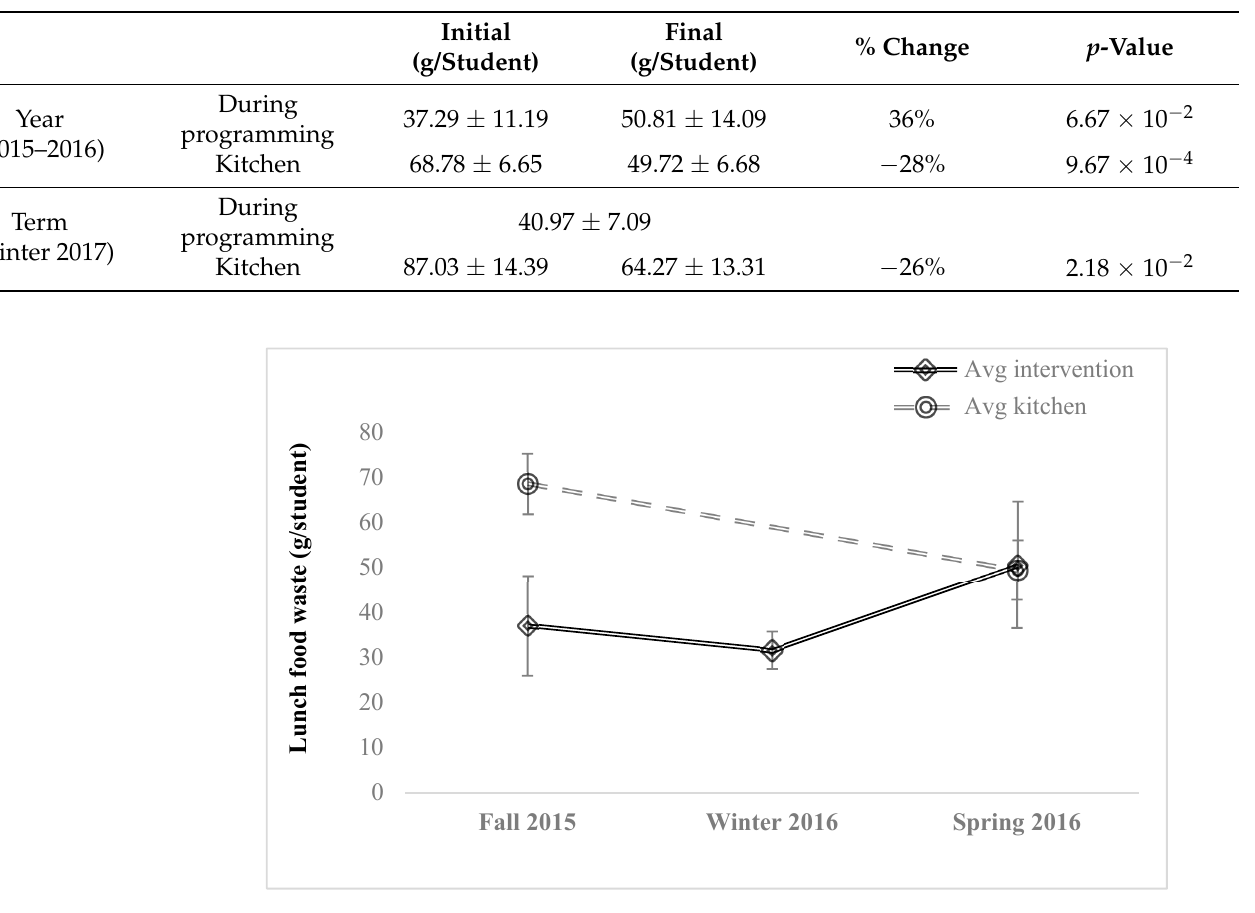
Figure 3. Trends in student food waste (g/lunch) as measured at the food waste buffet (in view of students) and compost kitchen weights (out of sight of students) over the year of programming (Fall 2015 to Spring 2016). Data was collected by recovering all wasted food during lunch for a week and taking the average of that waste based on customer number data (provided by the cafeteria). Standard deviation indicated with error bars.